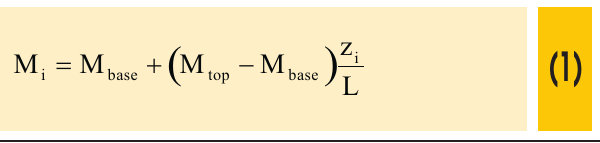
Figure 3 – Moment-curvature relationship for a load N